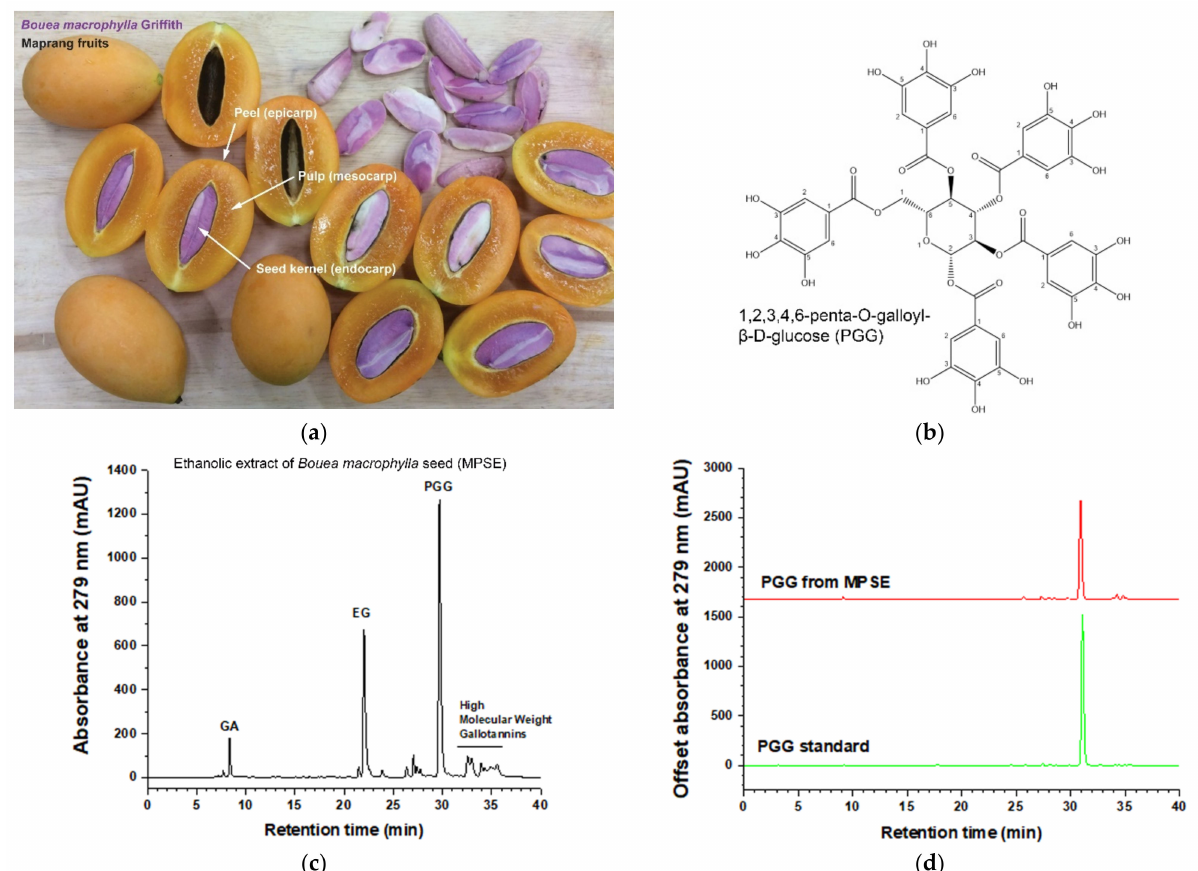
Figure 1. Maprang ( Bouea macrophylla ) fruits and their seed extract phytochemical characterization. ( a ) Maprang ( Bouea macrophylla ) fruits and their three major parts, peel, pulp, and seed kernel. ( b ) Chemical structure of 1,2,3,4-6-pentyl- O - galloyl- β - D -glucose (PGG). ( c ) HPLC profile of ethanolic extract of Maprang seed extract (MPSE). ( d ) PGG isolated from MPSE (top) and standard PGG samples